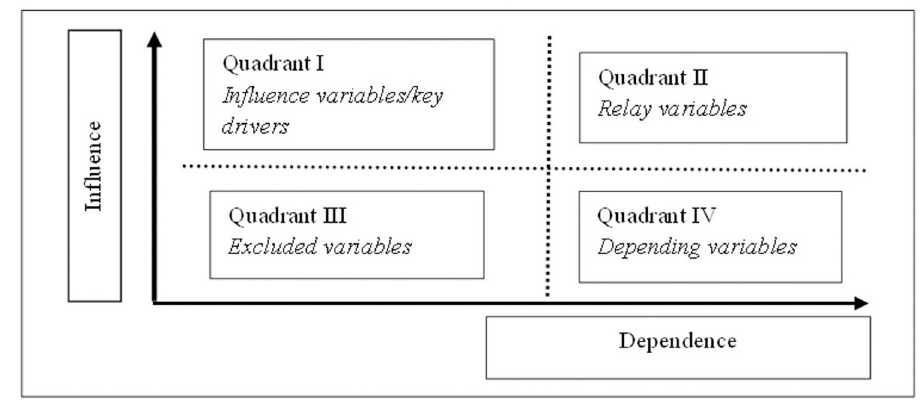
Fig 1. Influence and dependence